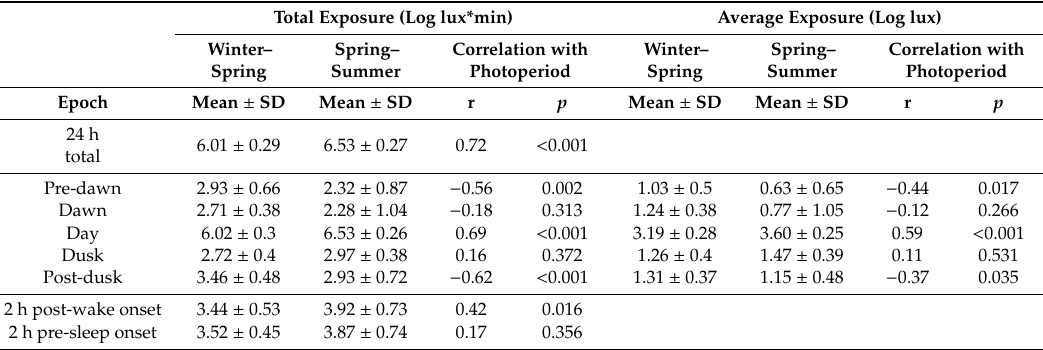
Figure 2. Photoperiod-related differences in photopic light exposure in the Old Order Amish. ( A ) Mean ± SEM daily pattern of photopic light exposure in 33 OOA subjects during winter/spring or spring/summer. ( B ) Mean ± SEM pattern of photopic light exposure for subjects above as a function of sun position around dawn or dusk. ( C ) Mean ± SEM pattern of photopic light exposure for subjects above relative to actimetry-defined wake onset and sleep onset timing. ( D – F ) Seasonal changes in pre-dawn ( D ), daytime ( E ) and post-dusk ( F ) total light exposure (lux*min) as a function of difference in photoperiod length for the 33 OOA subjects. Table 2. Light exposure under short and long photoperiods. Shows total (lux values summed over each min of exposure) and average illuminance (mean ± SD) for each analysis epoch tested under winter / spring (short) and spring / summer (long) photoperiods. Conventions as in Table 1. Total Exposure (Log lux*min) Average Exposure (Log